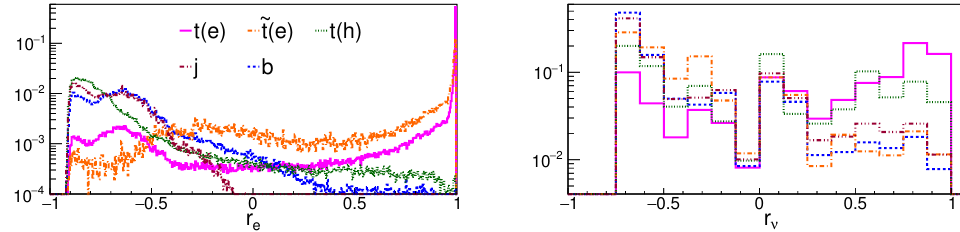
Figure 5 . Distribution of BDT responses r e (left), and r (cid:23) (right) respectively. See eqs. (2.20) and (2.21) for the de(cid:12)nitions of BDT